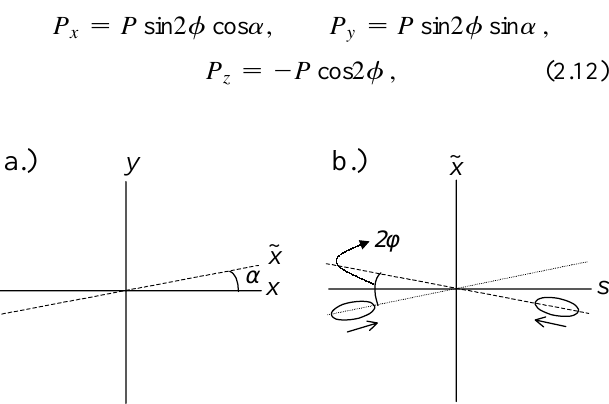
FIG. 1. (a) defines the crossing plane angle a in the ( x - y ) plane and (b) depicts the total crossing angle 2 f in the ( ˜ x - s )